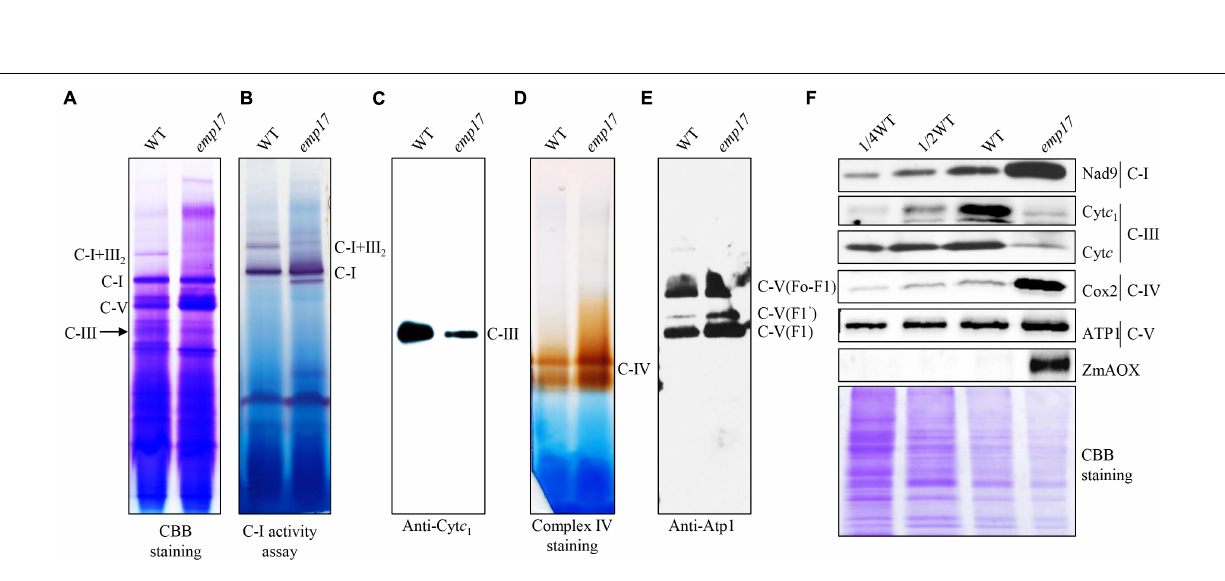
Frontiers in Plant Science |